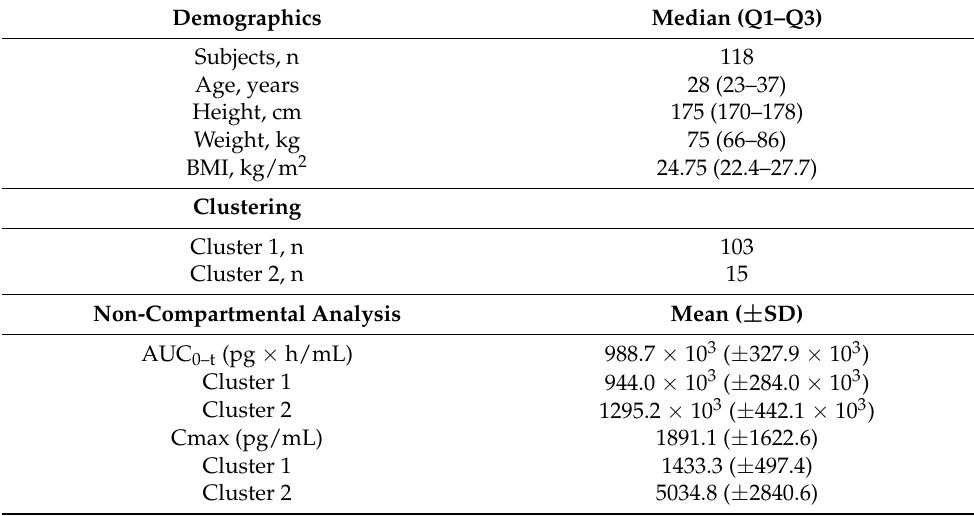
Table 1. Demographic, clustering and non-compartmental analysis